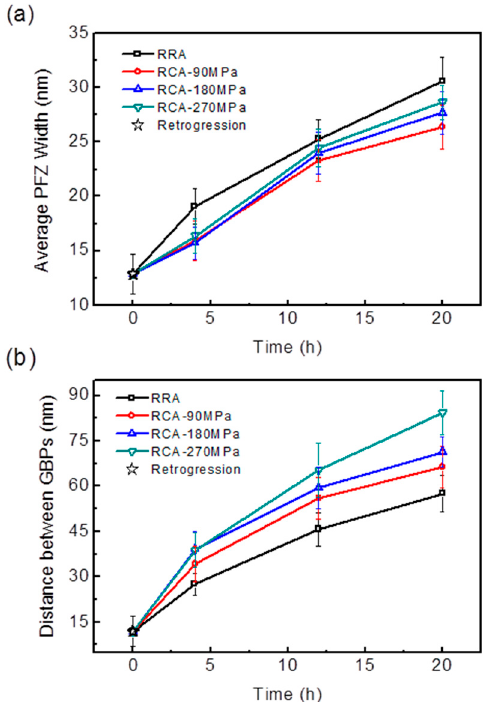
Figure 6. Evolutions of grain boundary microstructures of the retrogressed 7B04-T651 aluminum alloy during aging treatments: ( a ) the average width of GBPs; ( b ) the mean distance between GBPs.